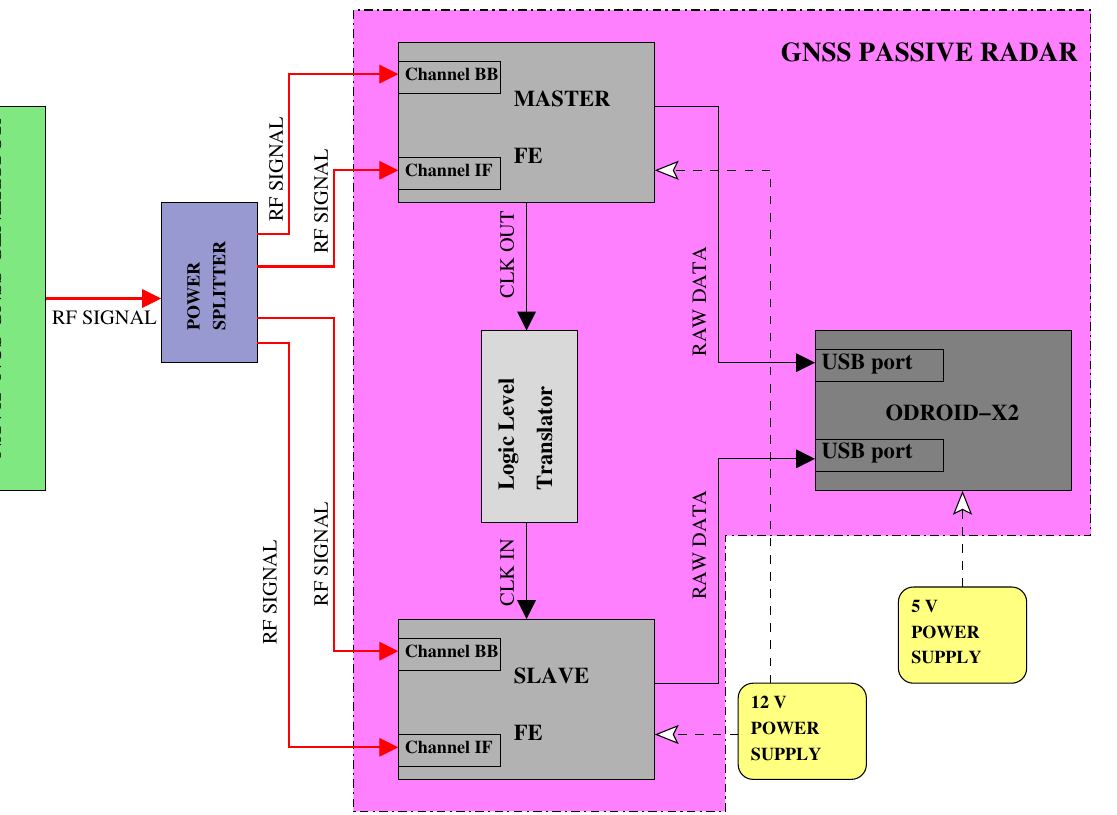
Figure 5. In-laboratory test setup with the simulated scenario.